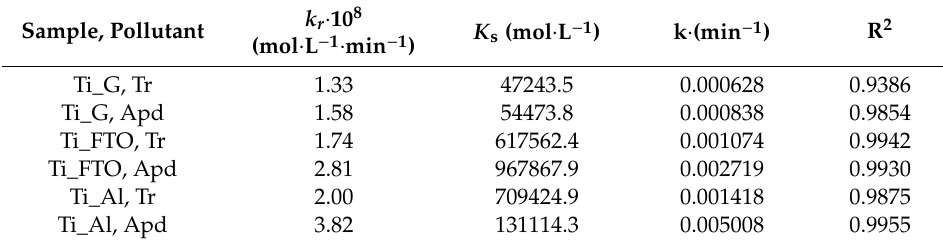
Table 5. Kinetic parameters based on Equation (4) for irradiation scenario 7.